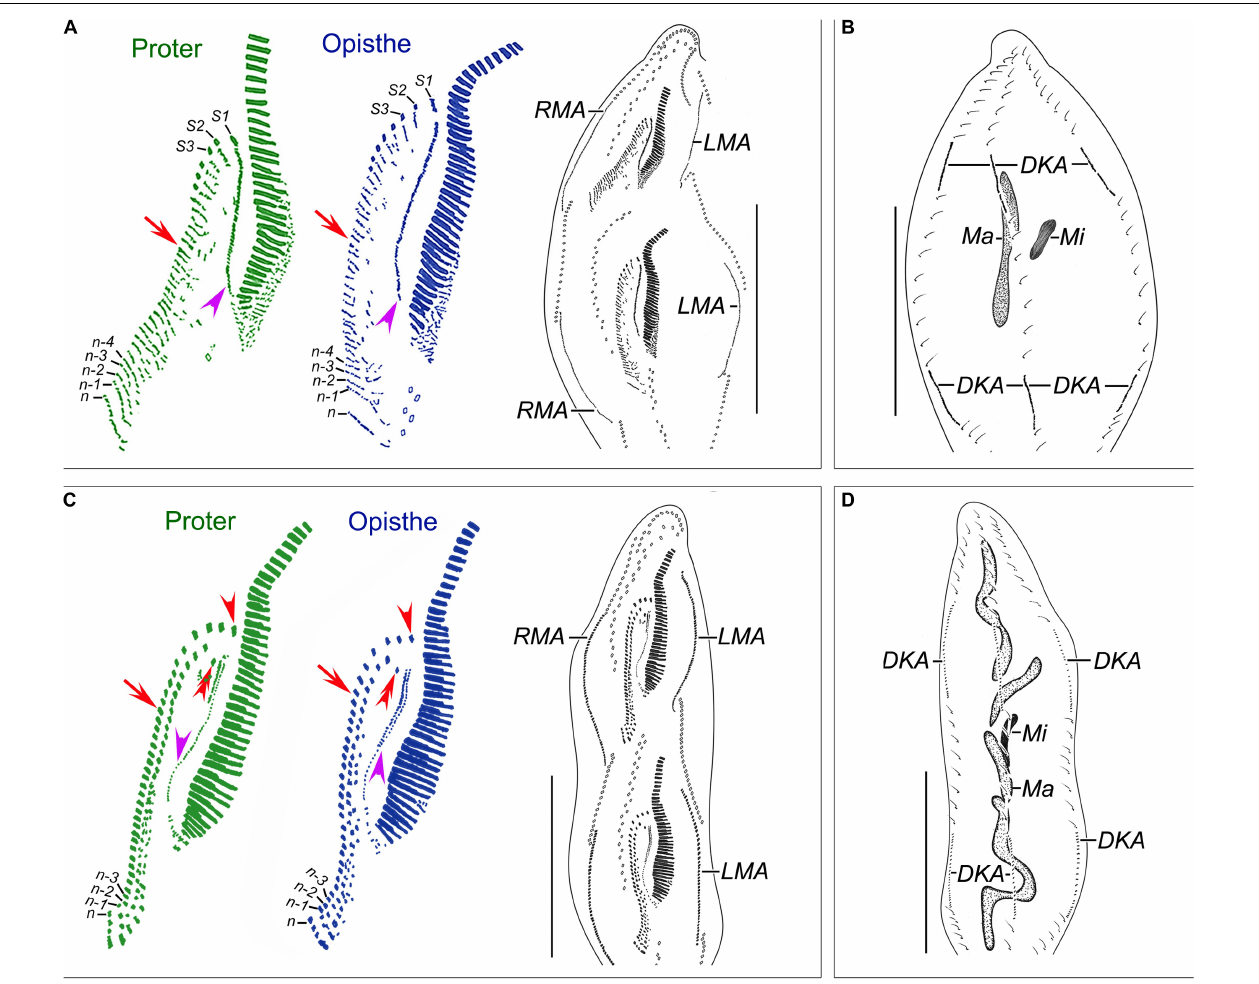
FIGURE 4 | Nothoholosticha luporinii n. sp., a late mid-divider (A,B) and a late divider (C,D) after protargol impregnation. Magnified details of the proter’s ciliature are in green colour, while those of the opisthe’s ciliature are in blue colour. (A,B) Ventral (A) and dorsal (B) views of a late mid-divider, showing the undulating membrane anlagen (purple arrowheads), frontal-midventral-transverse cirral anlagen (red arrows), the anlagen for marginal cirral rows and dorsal kineties, and the dividing macronuclear mass. (C,D) Ventral (C) and dorsal (D) views of a late divider, showing the buccal cirri (red double-arrowheads), frontal cirri (red arrowheads), undulating membranes (purple arrowheads), frontal-midventral-transverse cirral anlagen differentiating into cirri (red arrows), and dividing macronucleus. DKA, dorsal kinety anlagen; LMA, left marginal cirral row anlagen; Ma, macronucleus; Mi, micronuclei; n , last frontal-midventral-transverse cirral anlage; n–1 , n–2 , n–3 , n–4 , second, third, fourth, and fifth rearmost frontal-midventral-transverse cirral anlagen; RMA, right marginal cirral row anlagen; S1–3, first, second, and third streaks. Scale bars = 140 µ